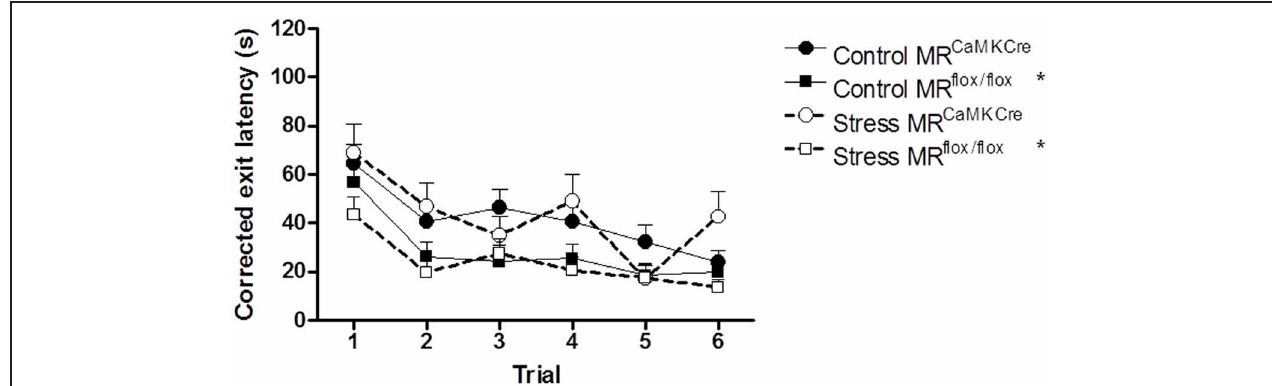
FIGURE 4 | Corrected exit latency. Subtraction of the latencies to leave the center from the latency of the first visit of the exit hole still resulted in longer latencies to locate the exit in MR CaMKCre mice compared to MR flox / flox mice, independent of stress. Black circles with the solid line are control MR CaMKCre